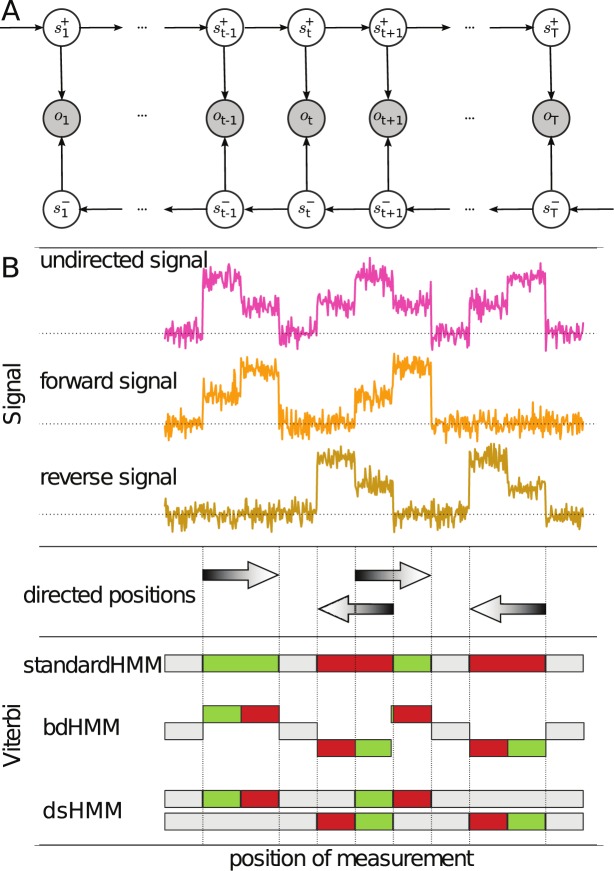
(A) Graphical representation of a dsHMM showing two hidden state chains \documentclass[12pt]{minimal}
\usepackage{amsmath}
\usepackage{wasysym}
\usepackage{amsfonts}
\usepackage{amssymb}
\usepackage{amsbsy}
\usepackage{upgreek}
\usepackage{mathrsfs}
\setlength{\oddsidemargin}{-69pt}
\begin{document}
}{}$\lbrace s_{1}^{+},\dots ,s_{T}^{+}\rbrace$\end{document} and \documentclass[12pt]{minimal}
\usepackage{amsmath}
\usepackage{wasysym}
\usepackage{amsfonts}
\usepackage{amssymb}
\usepackage{amsbsy}
\usepackage{upgreek}
\usepackage{mathrsfs}
\setlength{\oddsidemargin}{-69pt}
\begin{document}
}{}$\lbrace s_{1}^{-},\dots ,s_{T}^{-}\rbrace$\end{document} which run in opposite direction (white circles). Each state pair \documentclass[12pt]{minimal}
\usepackage{amsmath}
\usepackage{wasysym}
\usepackage{amsfonts}
\usepackage{amssymb}
\usepackage{amsbsy}
\usepackage{upgreek}
\usepackage{mathrsfs}
\setlength{\oddsidemargin}{-69pt}
\begin{document}
}{}$(s_{t}^{+},s_{t}^{-})$\end{document} emits an observation ot, t = 1, ..., T (gray circles). (B) Viterbi paths inferred from a synthetic data set using three different HMM models. The top panel shows a simulated ChIP experiment (purple track) and an RNA-Seq experiment with forward (orange track) and reverse strand (brown track) expression data for a genomic region containing partly overlapping genes (arrows in the middle panel) located on both DNA strands. The bottom panel shows the Viterbi paths obtained from the standard HMM, the bdHMM and the dsHMM with three hidden states: an intergenic state (gray) and two gene-specific states (red and green). For the bdHMM, equivalent forward and reverse states are indicated by the same color, positioned either above (forward direction) or below (reverse direction) the undirected gray states.